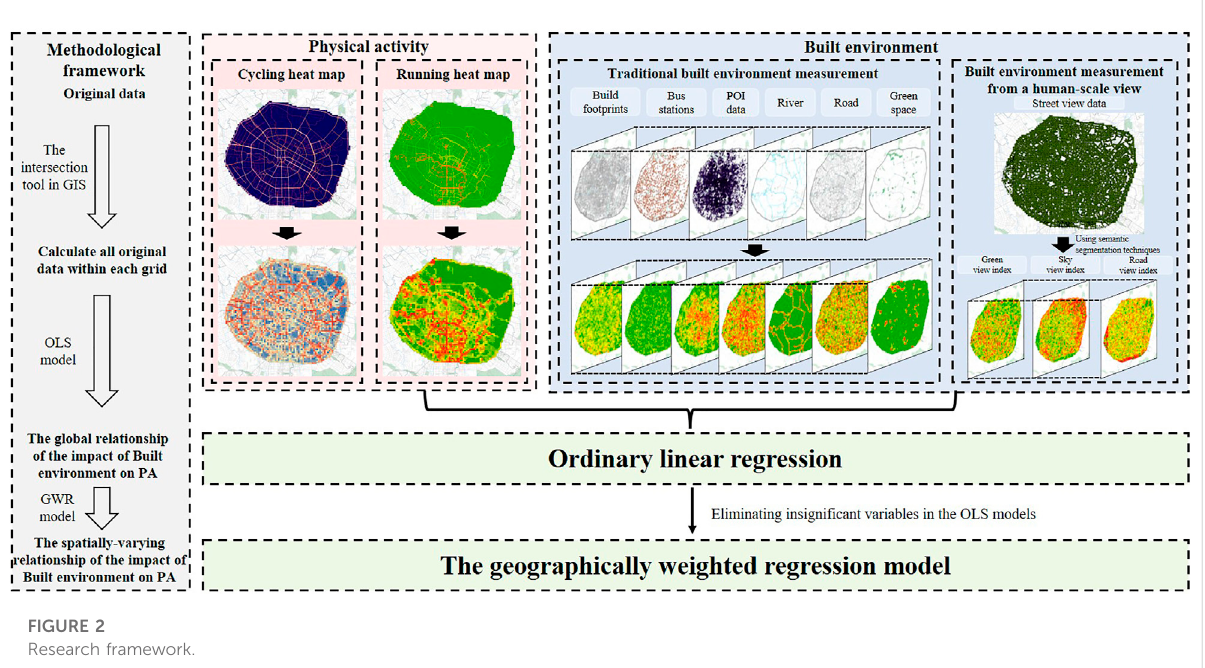
FIGURE 2 Research